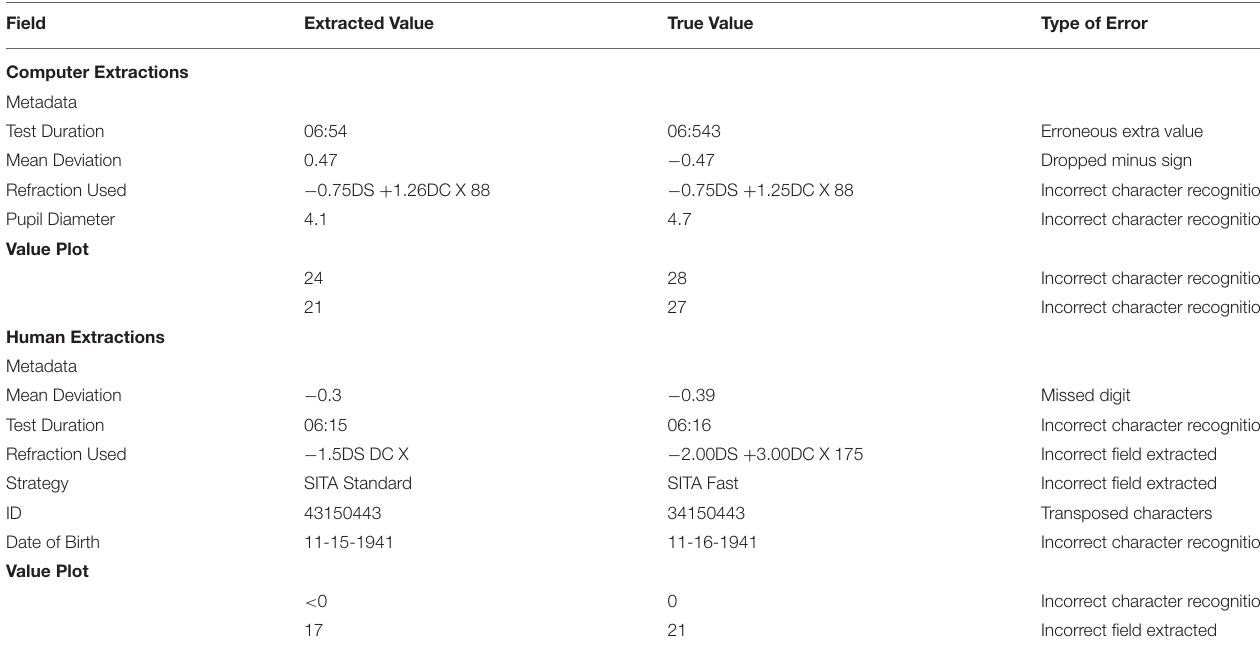
TABLE 6 | Examples of extraction